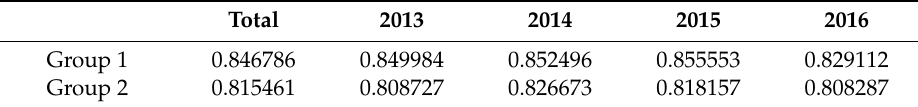
Table 3. 2013–2016 group e ffi